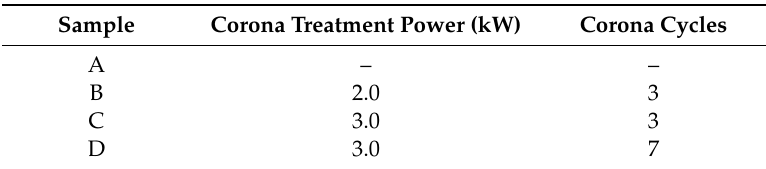
Table 1. The experimental conditions of corona discharge treatment for the biaxially oriented polypropylene (BOPP)